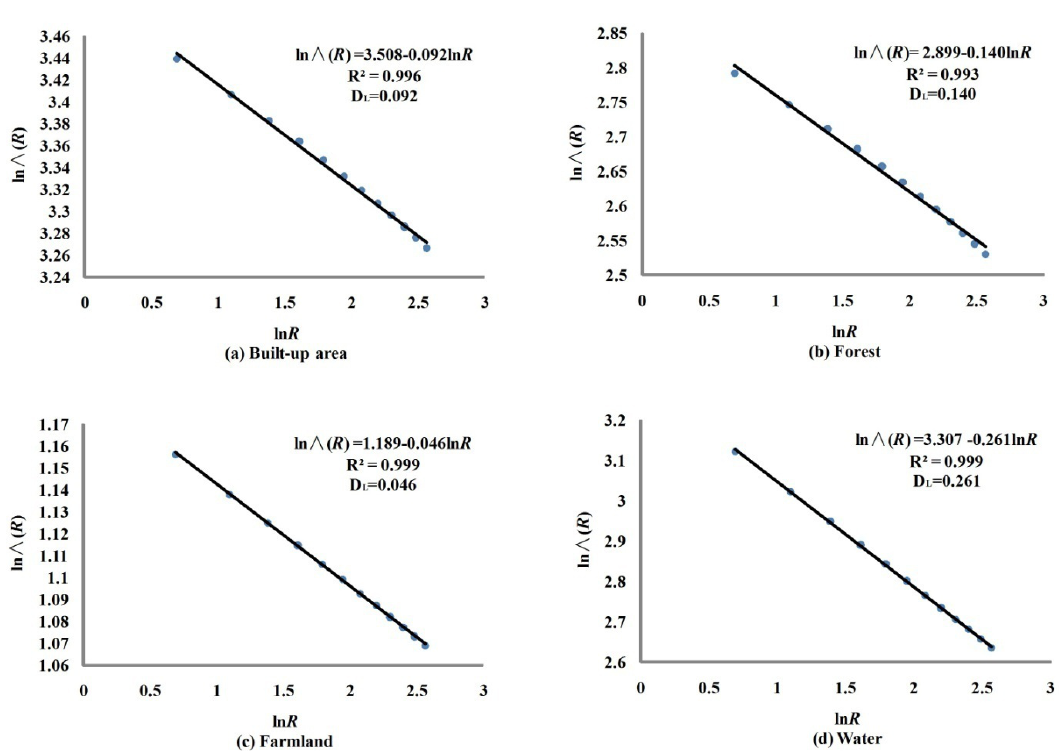
Figure 9. The lacunarity dimension results for four land use types in Wuhan City: ( a ) Built-up area, ( b ) Forest, ( c ) Farmland and ( d )